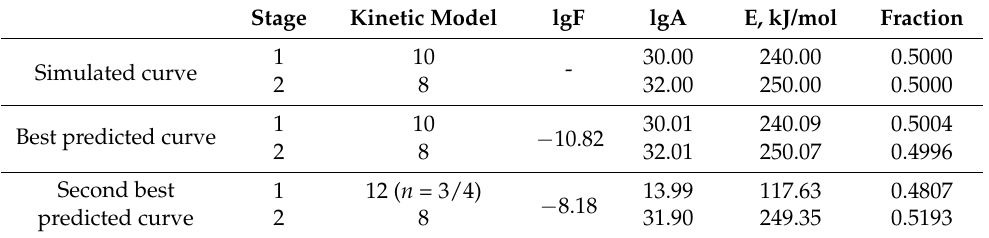
Figure 1. Simulated two-stage DTG curve built using the kinetic parameters from Table 2. Table 2. Comparison of kinetic parameters for simulated and predicted DTG curves.